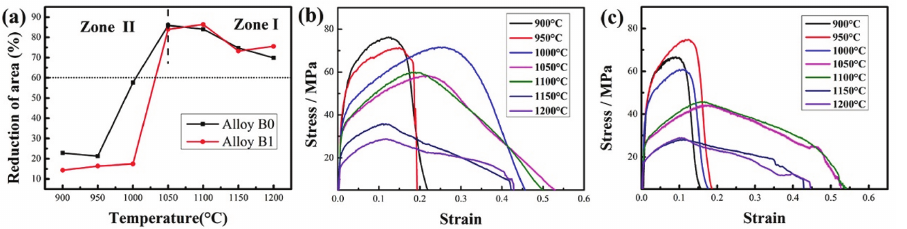
Figure 2: The characteristic curves of the investigated alloys at different test temperatures: (a) reduction of area curves; (b) the stress – strain curves of alloy B0; (c) the stress – strain curves of alloy